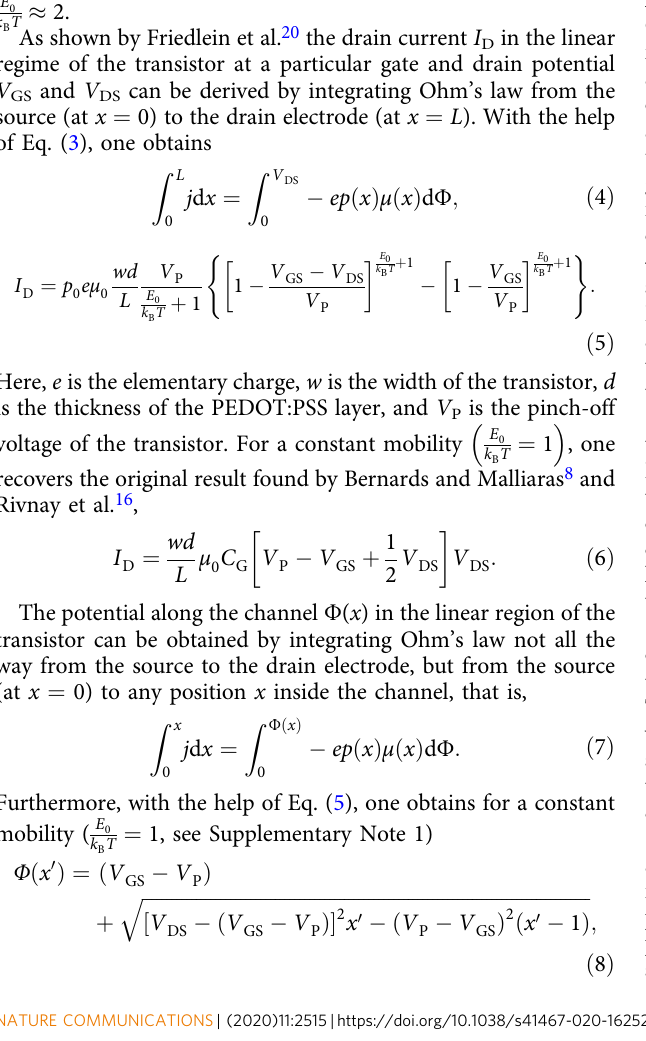
V DS,sat = V GS − V P .